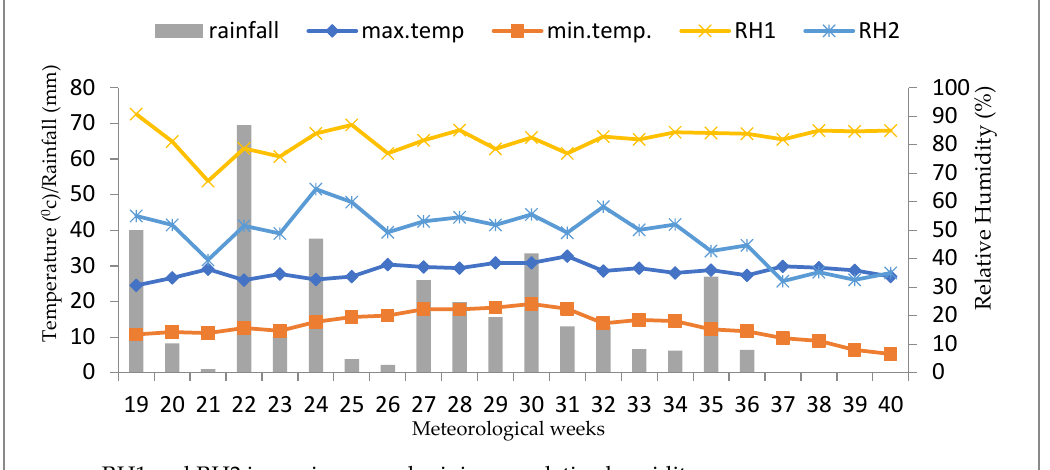
Figure 1. Average weekly meteorological data (2017).